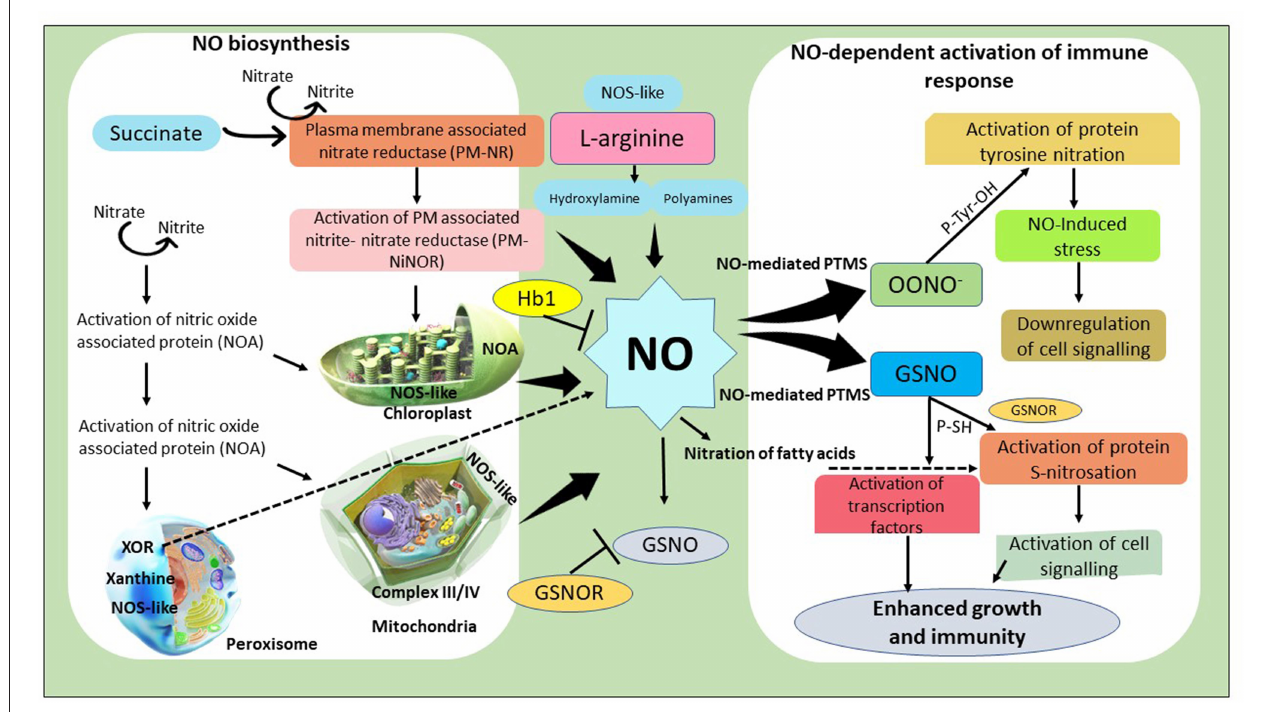
FIGURE 2 | Schematic representation of nitric oxide (NO) biosynthesis in different subcellular compartments in plants detailing about different biochemical reactions involved in biosynthesis and the effect they exert after they are released from respective compartments. In addition, details about different mode of NO production that occur in plants via L-arginine pathway has also been discussed and how the function of NO is affected by other signaling molecules has also been shown. Furthermore, mechanisms involved in the regulation of NO-dependent activation of immune response and activation of other defense responsive genes/proteins which ultimately leads to improve plant growth and development is also shown. PM-NR, Plasma membrane bound nitrate reductase; NiNOR, Plasma membrane bound Nitrite-nitric oxide reductase; NOA, NO associated protein; XOR, Xanthine oxidoreductase; NOS, Nitric oxide synthase; GSNO, S -Nitrosoglutathione; GSNOR, S -Nitrosoglutathione reducatse; PTMs, Post-translational modifications; OONO, peroxynitrite; Hb1, Heamoglobin